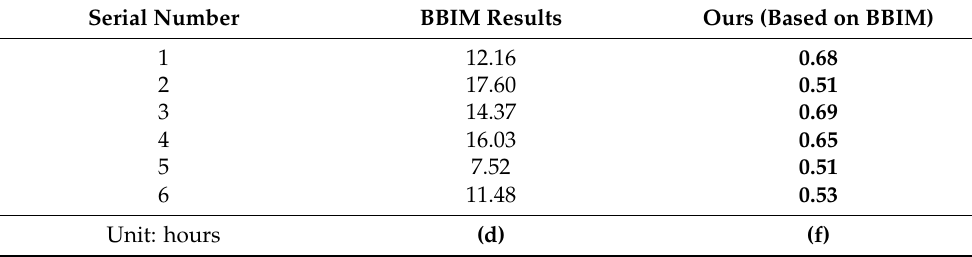
Table 5. Depth Image inpainting time results.